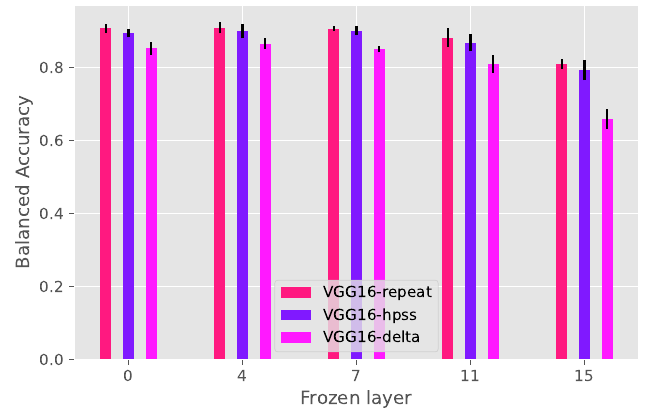
Figure 3. Comparison of three types of multi-view representation. Here, HPSS denotes harmonic– percussive source separation. Among the three representations, repeat-based spectrogram achieves the best